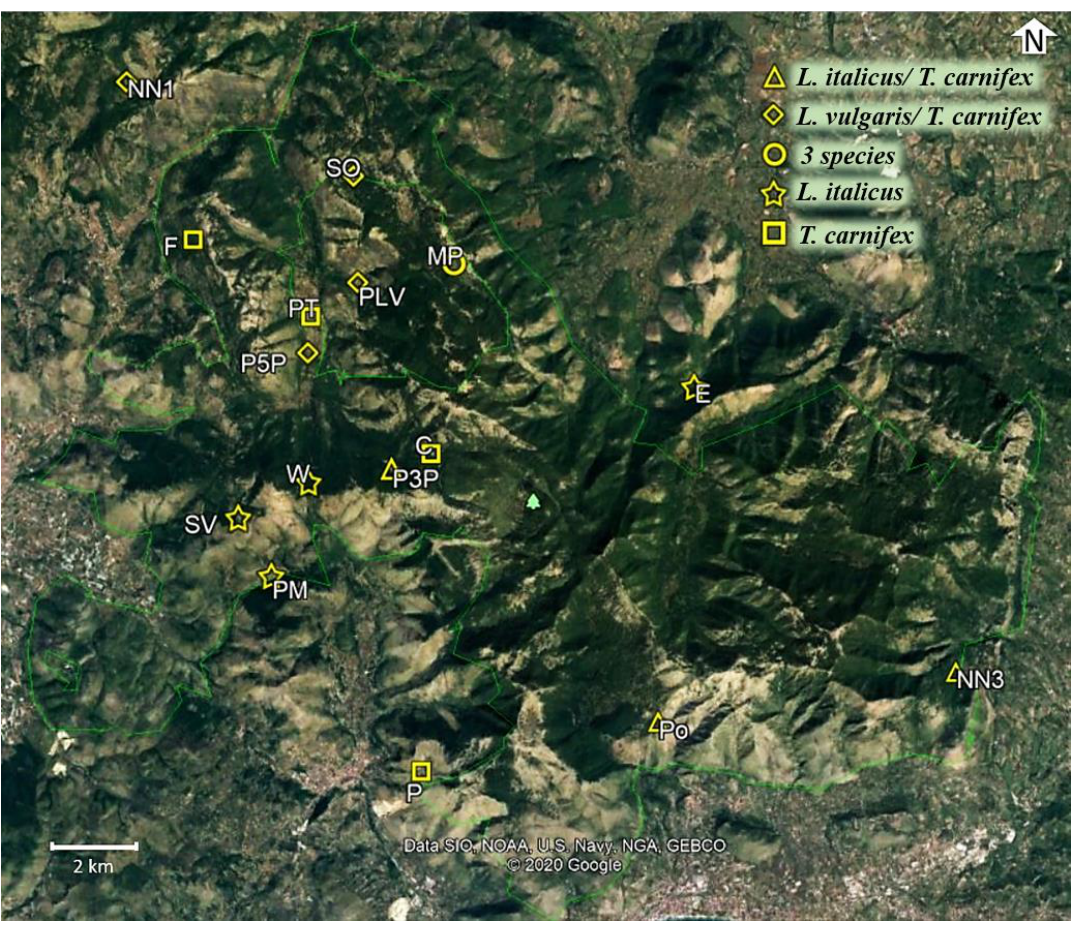
Figure 1. Distribution map of wells in the study area with indication of species coexistence. The numbers on the map refer to the well ID (Google Earth, earth.google.com//).